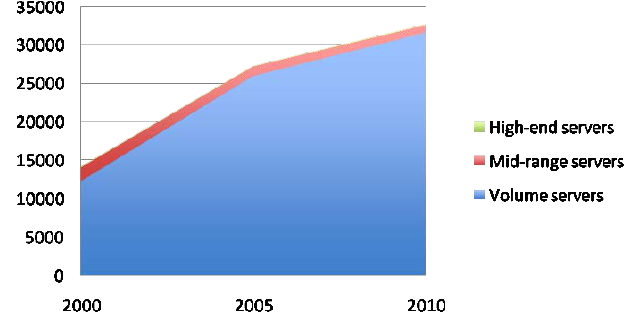
Figure 3. Electricity use by data centers (billion